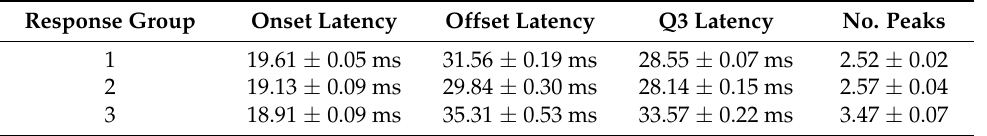
Table 3. Temporal parameters and number of major potential peaks of monosynaptic posterior root-muscle (PRM) reflexes and composite responses in tibialis anterior. Response